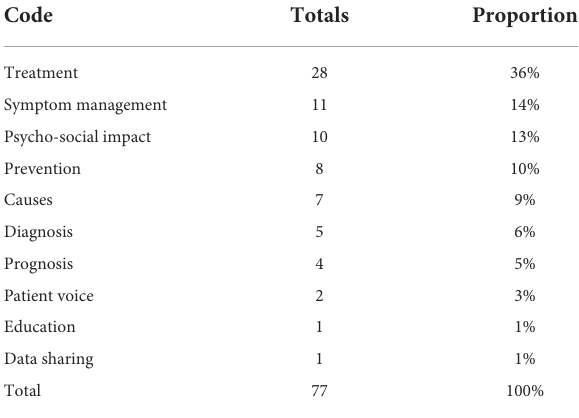
TABLE 2 Priorities identified in the